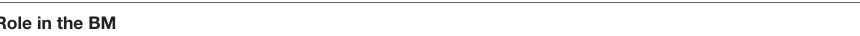
TABLE 1 | The BM niche